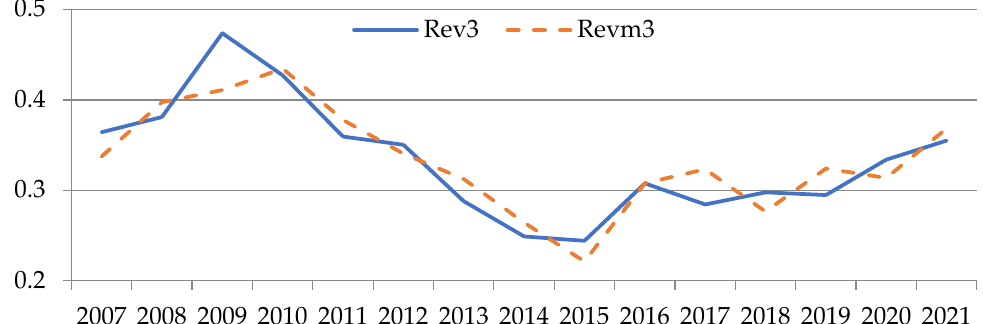
Figure 2. Comparison between real revenue and model value calculated by Formula (1) for industry No. 2 (author’s results).